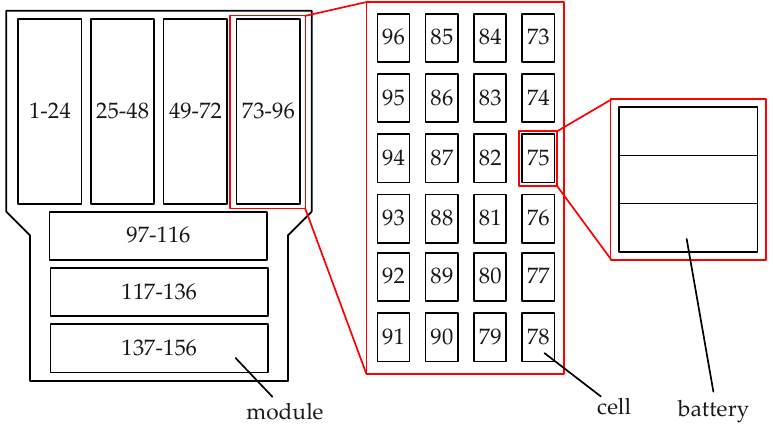
Figure 2. Cell layout within the battery pack.